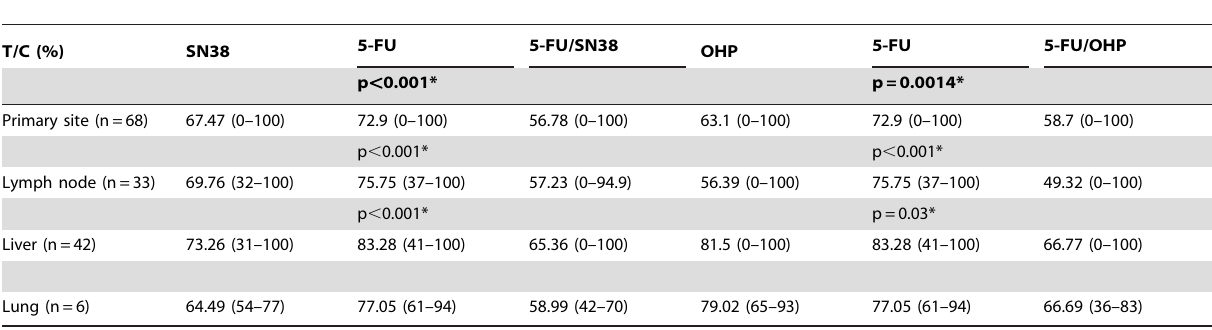
Table 2. Evaluation of combination agents in